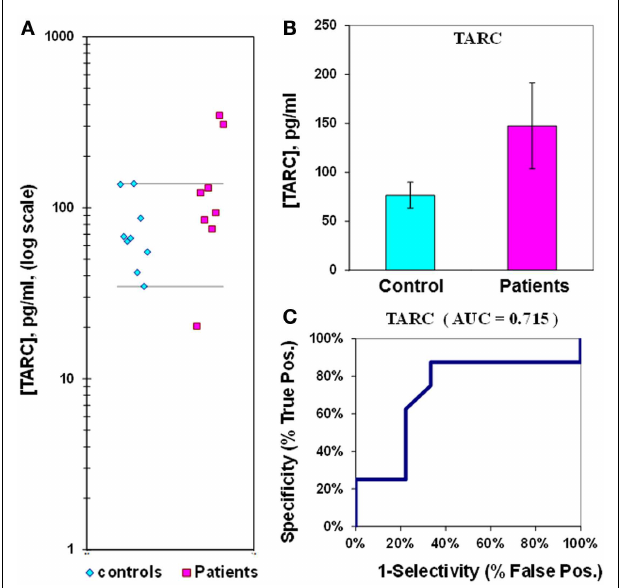
FIGURE 6 |Assay ofTARC in plasma from epilepsy patients and controls. (A) Dot-plot ofTARC concentrations in plasma (square, patients; diamond, controls). For values between the horizontal lines, the assay does not accurately discriminate between patients and controls. (B) Bar graph and error calculation for data in Part (A) . Difference is not significant for p = 0.068. (C) ROC curve for data in Part (A) , showing an area under the curve (AUC) value of 0.72.